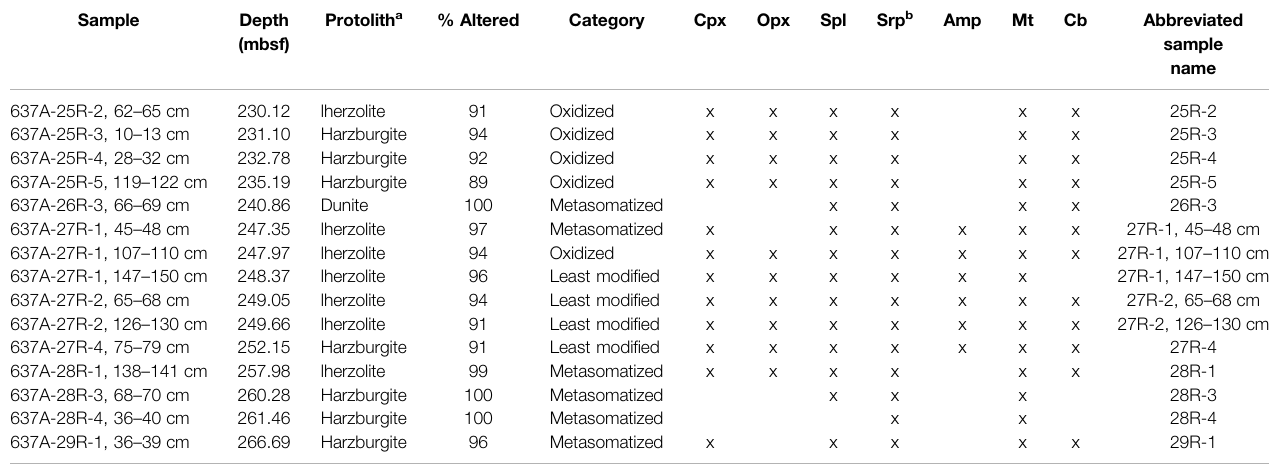
TABLE1| Overviewofinvestigatedsamples,estimatedprotolithtype,degreeofalteration,internalclassi fi cationofthealterationstate(cf. IronOxidationStateandMagnetite Contents ), and phase assemblages. Sample Depth